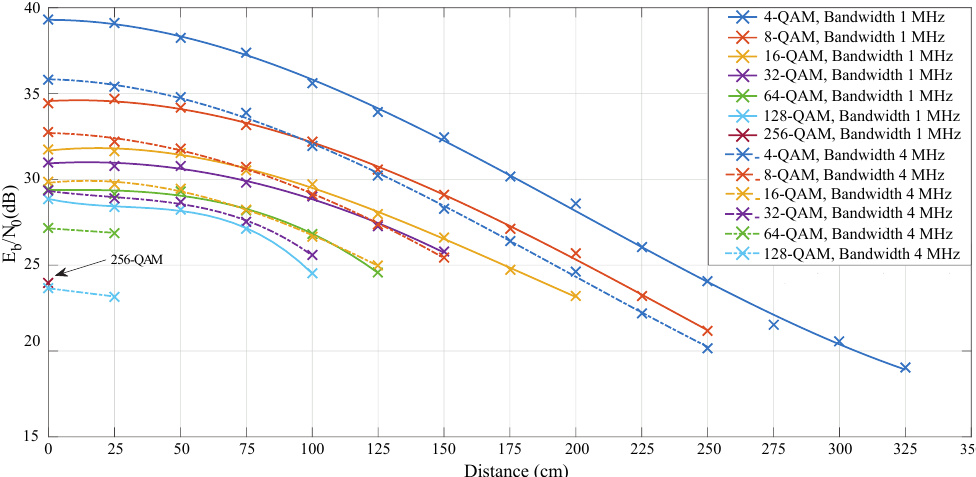
Figure 10. E b /N 0 / distance from center relationship for ceiling light with different M-QAM and bandwidths.